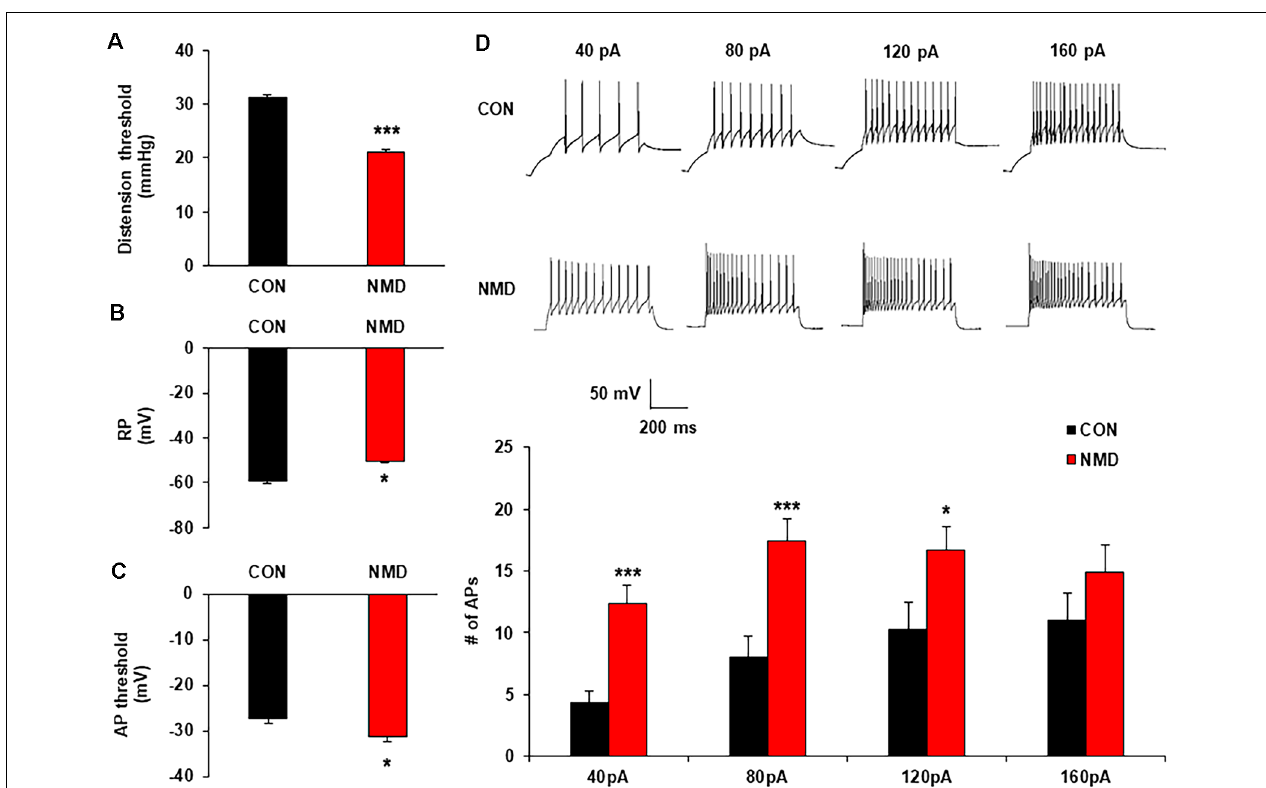
FIGURE 1 | Neonatal maternal deprivation (NMD) reduced visceral pain threshold and enhanced the neuronal excitability. (A) NMD rats developed chronic visceral pain (*** P < 0.001, n = 6 rats for each group, Tukey post hoc test following two-way repeated measures ANOVA). (B) NMD depolarized the resting membrane potential (RP; * P < 0.05, n = 17 cells for CON and n = 15 cells for NMD, two sample t -test). (C) NMD hyperpolarized the threshold of action potential (AP) in NMD rats when compared with CON (* P < 0.05, n = 10 cells for CON and n = 17 cells for NMD, two sample t -test). (D) NMD significantly enhanced the frequency of